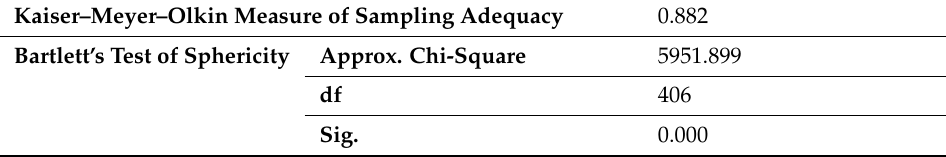
Table 2. KMO and Bartlett’s test of